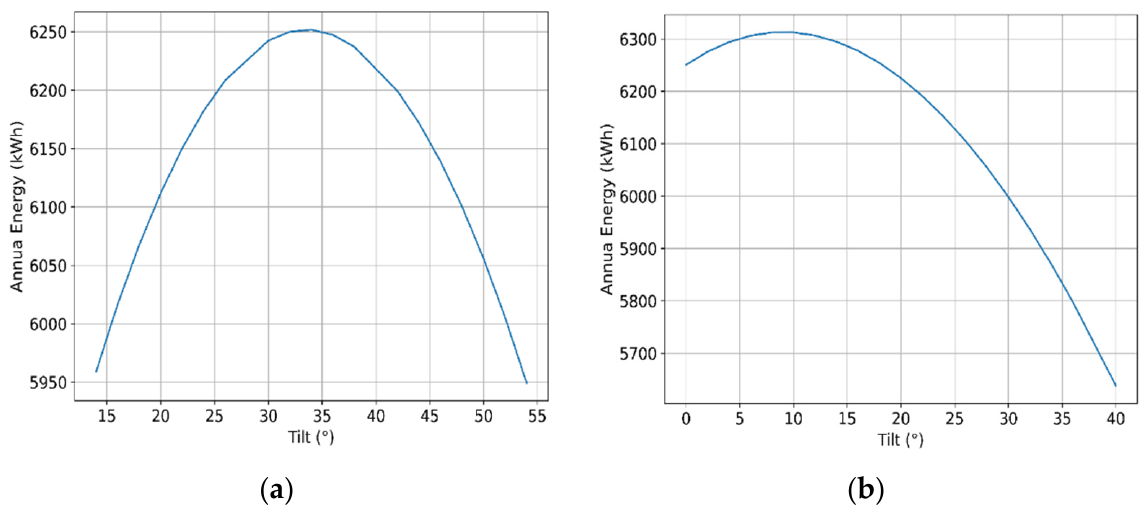
Figure 1. Annual energy production for a solar module in ( a ) London Ontario and ( b ) Lomé Togo as a function of tilt angle.